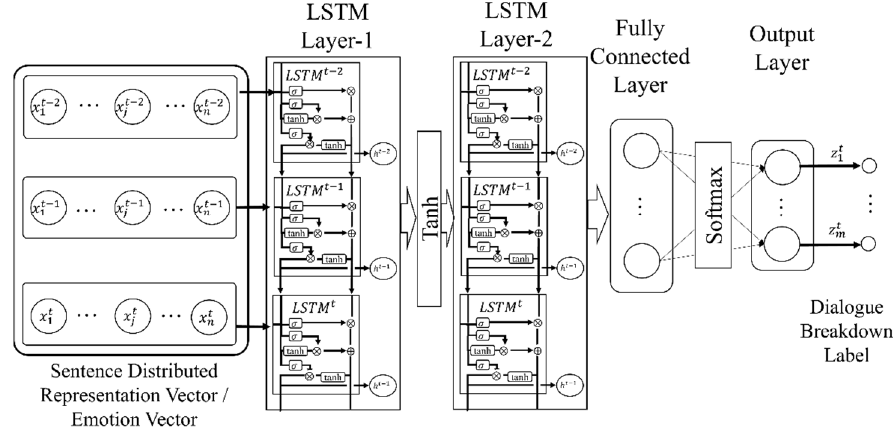
Figure 6. RNN network using sentence vector or emotion vector as feature.